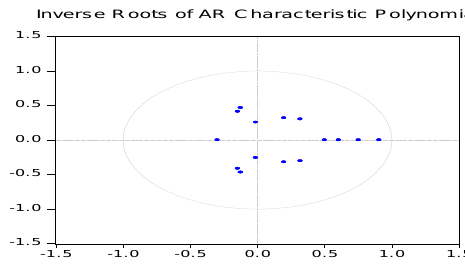
Fig. 1. The results of inverse roots of AR characteristics